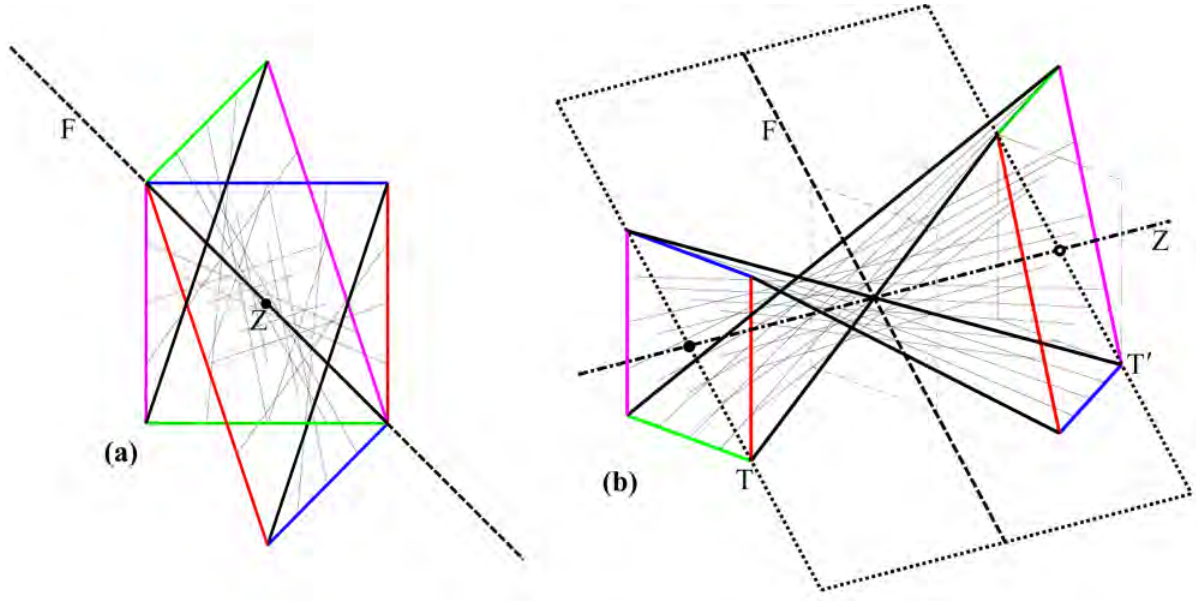
Figure 11 A pencil with divergency 4/4/ LJIM ++−= D at T. The pencil has a single line focus. The antisymmetric compo- nent has caused the principal meridional planes to rotate symmetrically towards each other becoming one at 135 °− 20 and bisecting the angle between the original principal meridional planes. (b) azimuth °− 20 40 °− 20 , elevation 18 °− 20 .